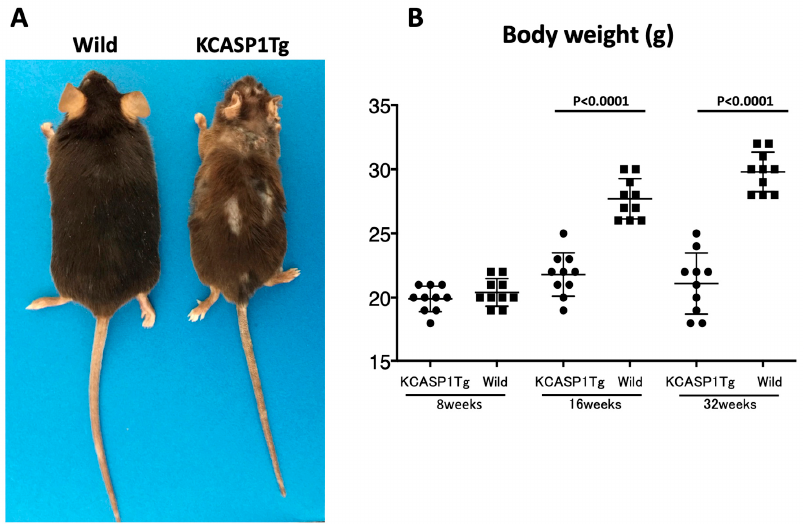
Figure 1. Phenotype and body weight. KCASP1Tg (keratin 14 ‐ specific human caspase ‐ 1 ‐ overexpressing transgenic) mice showed the scratching behavior and erosive dermatitis spread from the face to back skin. The clinical phenotype is similar to that of acute phase atopic dermatitis. The body of KCASP1Tg mice was smaller than that of wild ‐ type littermate mouse at 16 weeks of age ( A ). We compared body weight between KCASP1Tg mice and wild ‐ type littermates. The difference in body weight between the two groups was significant at 16 and 32 weeks of age ( p < 0.0001 for both groups, B ).